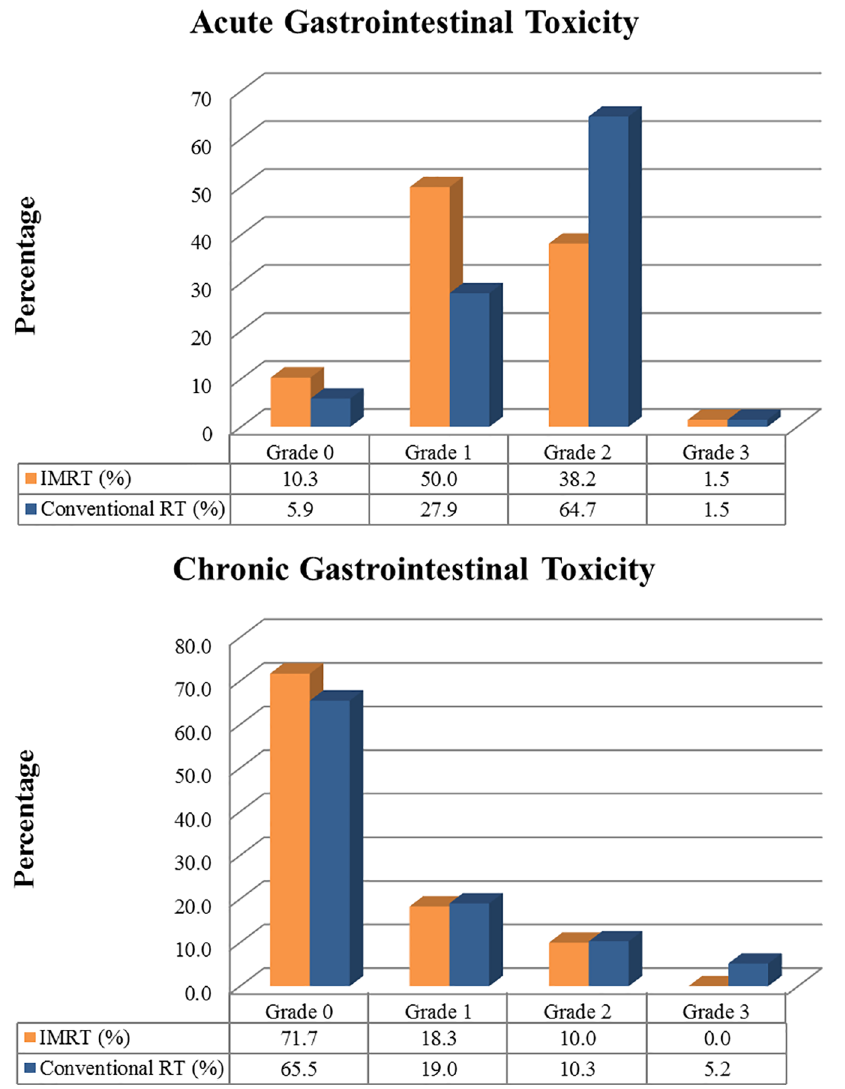
Fig 1. Incidence of GI toxicity according to radiotherapy technique. (a) Incidenceof acute GI toxicity (b) Incidenceof chronicGI toxicity.